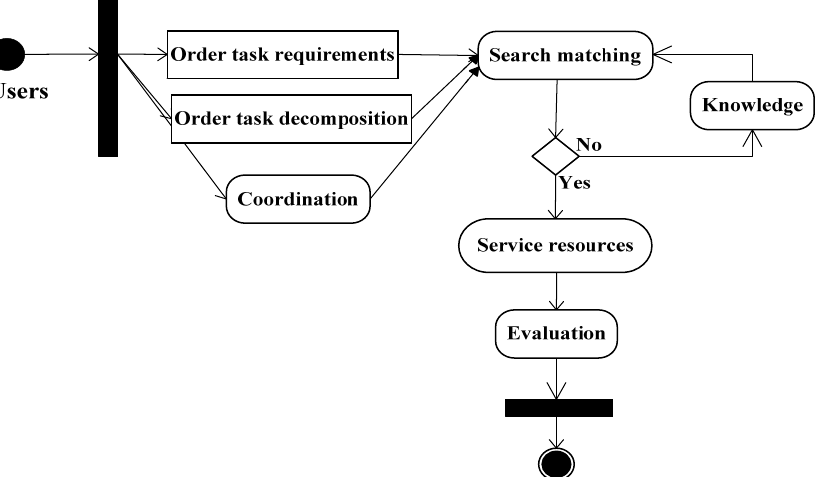
Figure 10. Flow chart of cloud service evaluation implementation based on the hybrid multi-objective BM-MOPSO evaluation model.